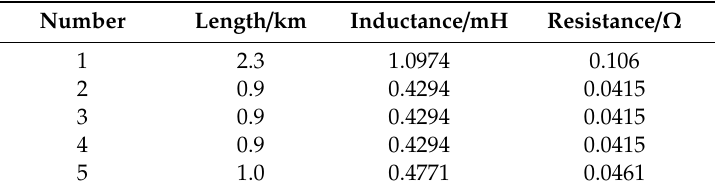
Table 3. Parameters of DC Cable.